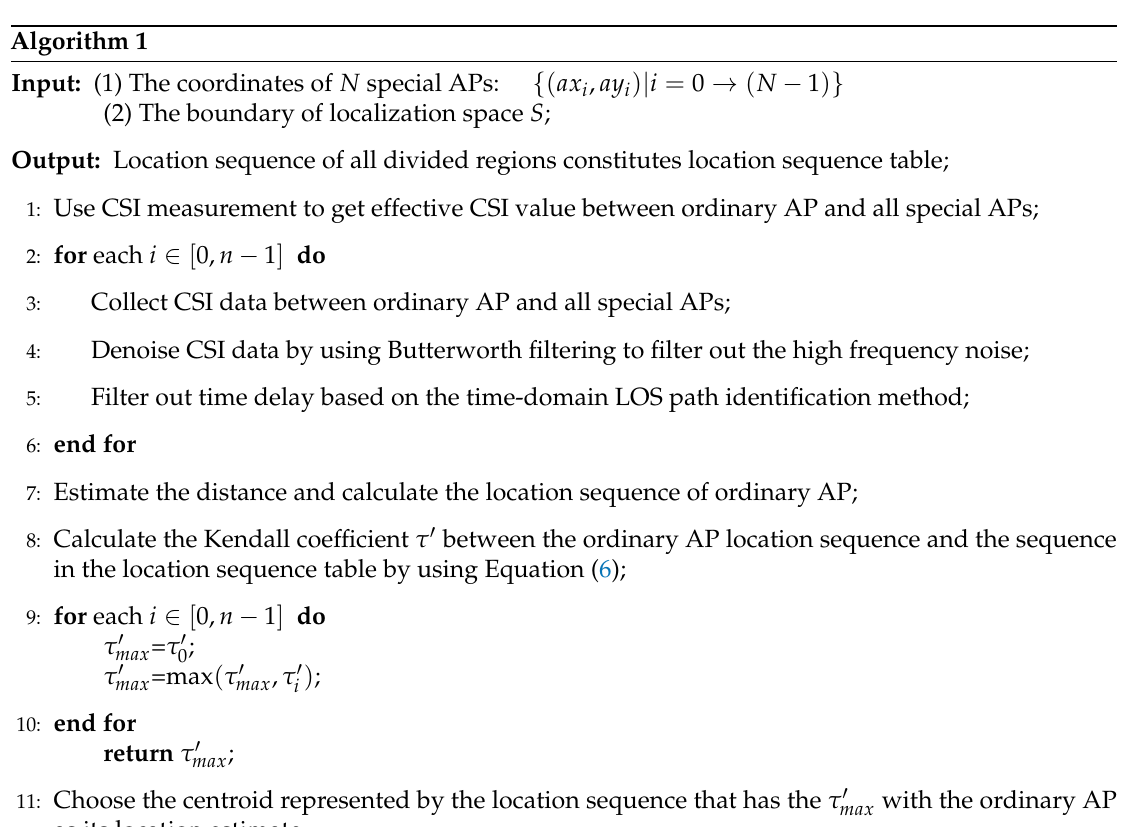
table; according to the optimized correlation to obtain the maximum value of τ max . Finally, the centroid of the region corresponding to the Kendall coefficient is the estimated position of the ordinary